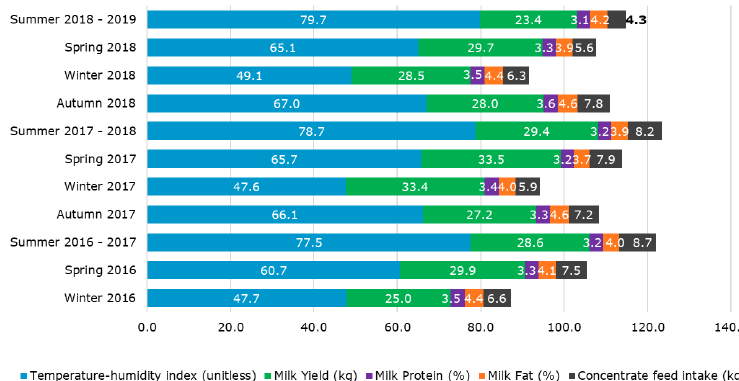
Figure 2. Mean values per season of each year for temperature-humidity index (THI 9 ) and the four parameters used as targets in the machine learning (ML) models to represent the effect of different weather patterns on potential heat stress, milk productivity, and quality.